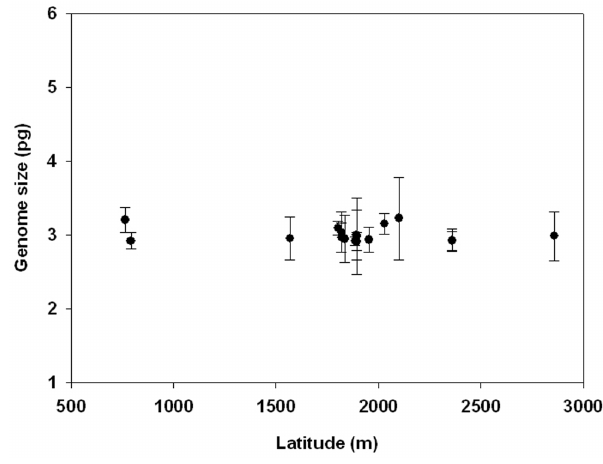
Figure 2. The relationship between genome size (pg) and latitudinal origins of 17 cultivars of C.sinensis var. assamica .